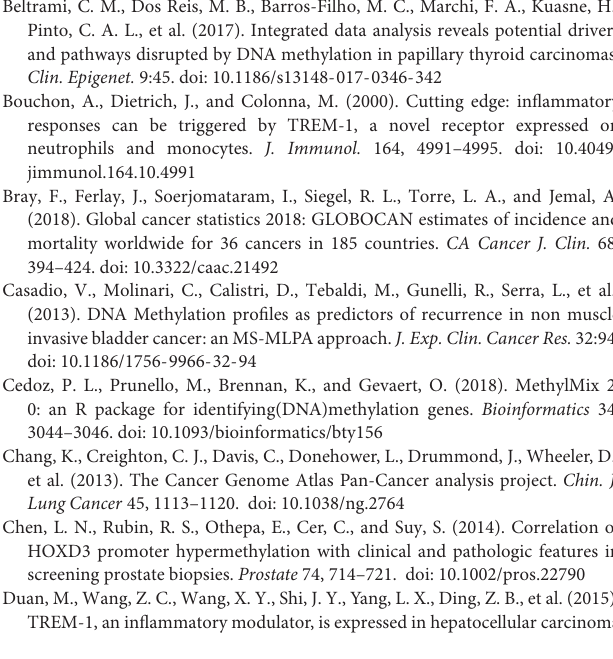
FIGURE S1 | The partial enriched GO terms (A–D) in GSEA analysis. FIGURE S2 | Validation of DNA methylation-driven genes in thyroid cancer cells. (A) Relative expression of RDH5 in cells treated with 5-aza-2-deoxycytidine (5-aza); (B) Relative expression of TREM1 in cells treated with 5-aza; (C) Relative expression of BIRC7 in cells treated with 5-aza; (D) Relative expression of